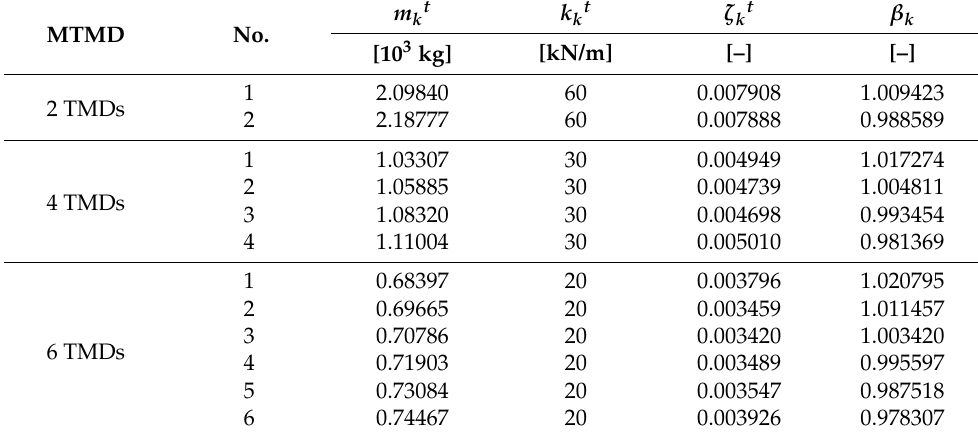
Table 7. Optimal m kt , ζ kt , β k values obtained for the J 1 objective